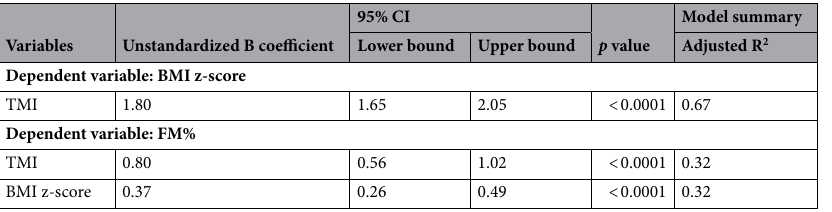
Table 5. Multivariable linear regression analyses for TMI associations in pediatric ALL survivors adjusted for age, sex, ethnicity, and risk status. Abbreviations: TMI, triponderal mass index; BMI, body mass index; FM%, fat mass percentage.